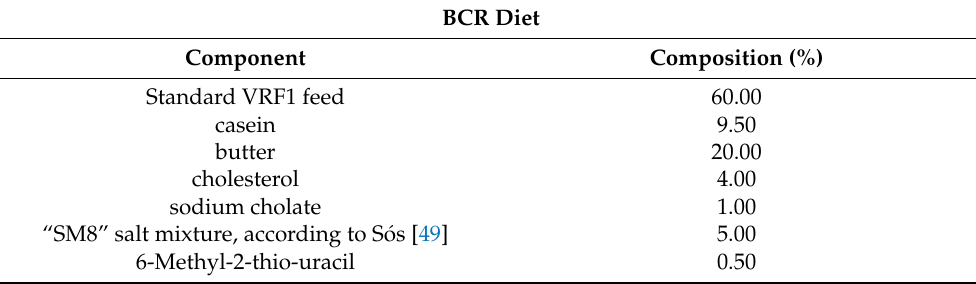
Table 2. Components of the special BCR diet.